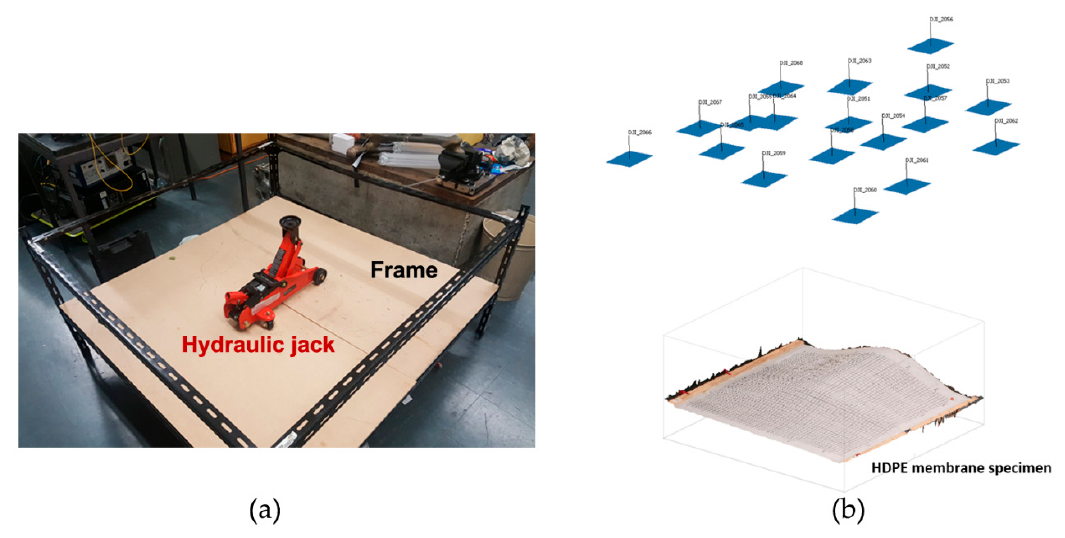
Figure 3. ( a ) Membrane deformation test apparatus. ( b ) Dense clouds of the membrane specimen via aerial images.